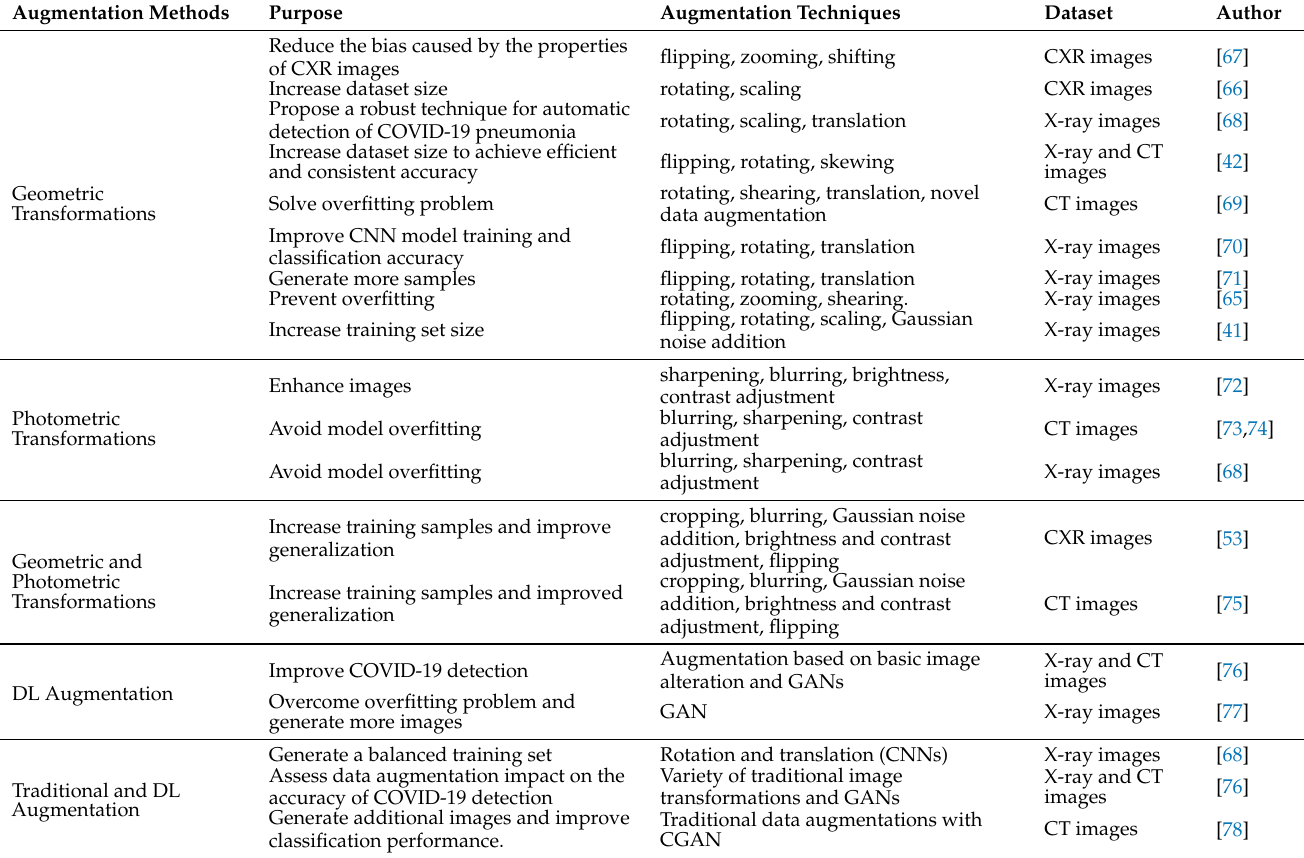
Table 5. Summary of augmentation